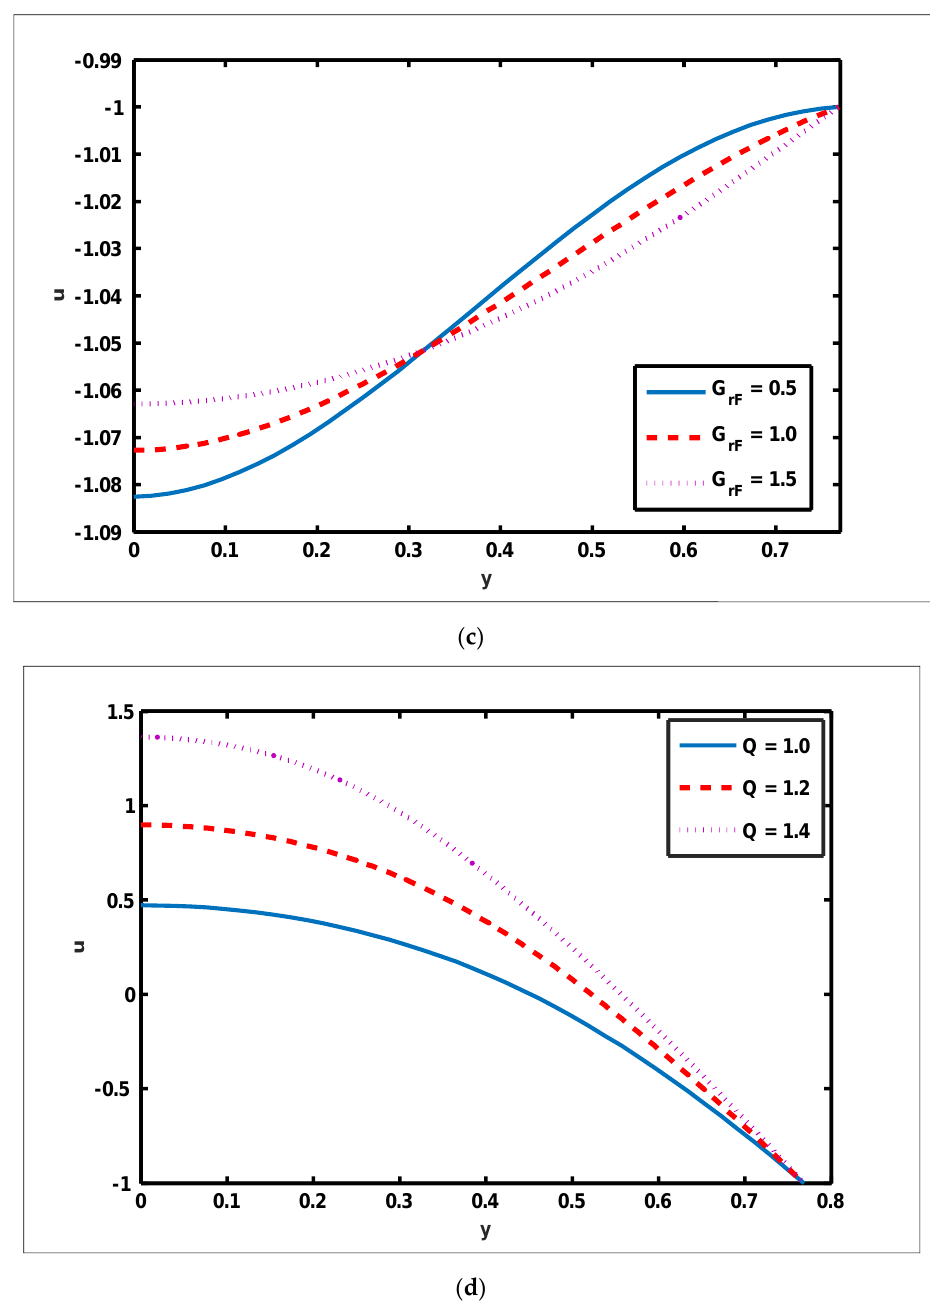
Figure 6. Velocity profile for Weissenberg number, solutal Grashof number, Grashof number of nanoparticles, and volume flow rate. Values of other physical parameters are ( a ) 𝑁 𝑡 = 0.3,𝑁 𝑇𝐶 = 1.2,𝑁 𝑏 = 0.4,𝑏 = 0.7,𝑎 = 0.3,𝑁 𝐶𝑇 = 0.9,𝑅𝑒 = 0.5,𝑆 1 = 0.3,𝑅 𝑚 = 0.5,𝐺 𝑟𝑐 = 1.4,𝑥 = 0.6,𝐺 𝑟𝑡 = 0.5,𝐺